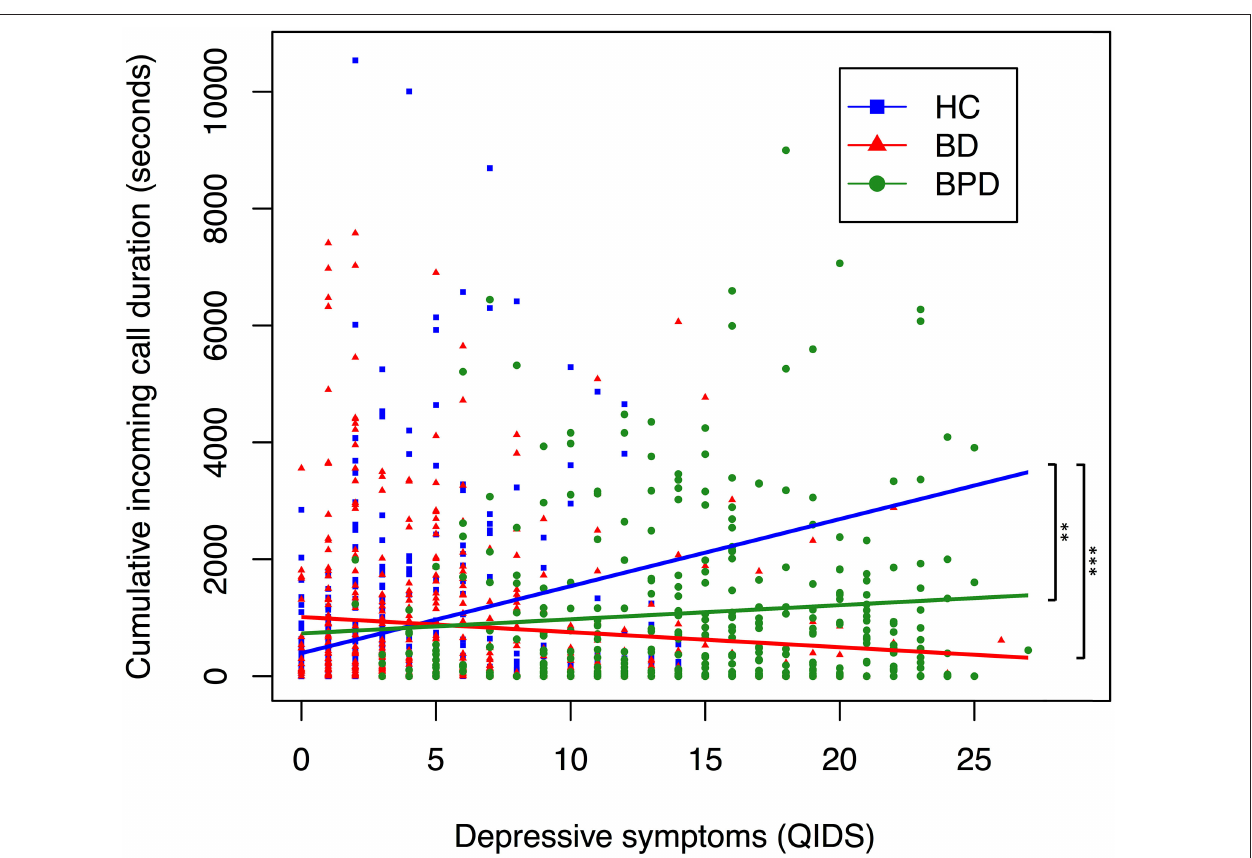
FIGURE 2 | Relationship between depressive symptoms and cumulative incoming call duration, by diagnostic group. A scatter plot displaying the relationship between depressive symptoms and cumulative total call duration. Each point corresponds to a participants’ depressive symptoms (measured by QIDS) and their cumulative incoming call duration (measured in seconds) in the 6 days preceding, and day of, a completed mood assessment. Color coding corresponds to diagnosis. Trendline coefficients are taken from linear mixed-effects regression models adjusted for age. Significance testing performed with HC as reference; *** p < 0.001, ** p < 0.01, * p < 0.05 (HC, n = 642; BD, n = 456; BPD, n =